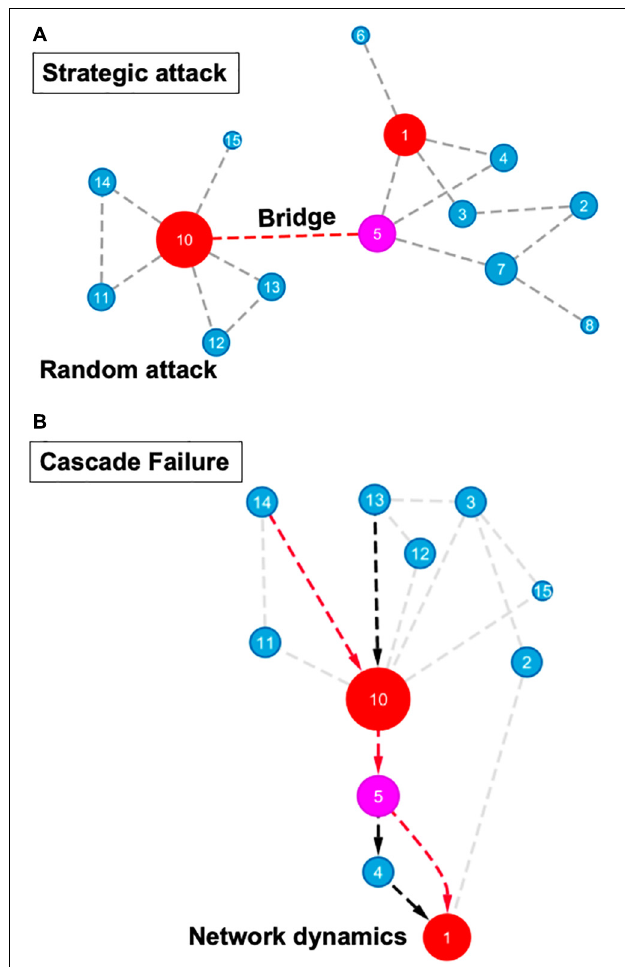
FIGURE 2 | Topological features in network robustness and resilience. (A) Node and edge percolations in strategic or random attacks are displayed. Highly connected nodes (hubs) are represented as red circles, high betweenness node (a bottleneck) is shown in magenta, blue circles represent remaining network nodes. Circle size correlates with node connectivity. A strategic attack involves the disruption of a bridge connecting two high centrality nodes, such as the one located between nodes #5 and #10. The degree of distribution and other connectivity measures are not important for random attacks (such as disruption of an interaction between two blue nodes). (B) Functional or structural redundancy as well as network dynamics to reduce cascade failure are shown. Red arrows indicate the mainstream information flow pathway while the black arrows depict an alternate pathway that allows rewiring information flow in a robust network. Circle colors and sizes correspond to features described in (A)